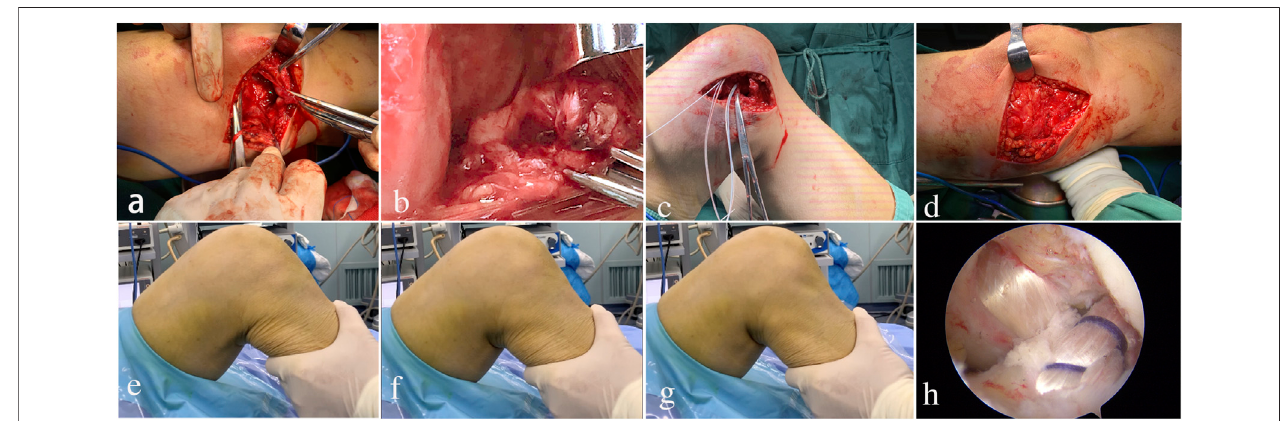
FIGURE2| Two-stagedoperationprocedures. (A,B) :instage-1,thedamagedMCLandothermedial structures wereexposed,whichwerefoundinterposed into thecondylarnotch; (C,D) :thetorn MCLand medial retinaculum werereplaced andrepaired,and thedislocated kneewasback tonormalalignmentfollowingthesuture ofthemedialjointcapsule; (E – G) :beforestage-2began,thedrawertestsfoundnotableanterior-posteriorinstability,thatis,theanteriordrawertest, (F) ,neutralposition, (G) , the posterior drawer test; (H) : the ACL and PCL reconstruction in stage-2.